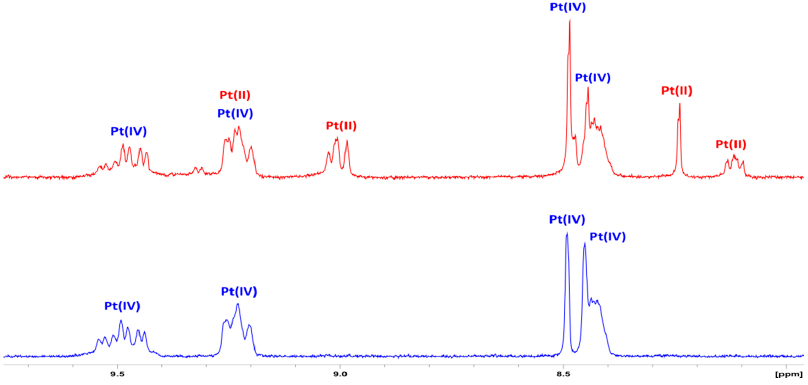
Figure 5. The 1 H NMR spectra of the aromatic region of 3 with 10X PBS in D 2 O, at 37 °C ( bottom ) and with ascorbic acid added ( top ), showing platinum(II) resonances.